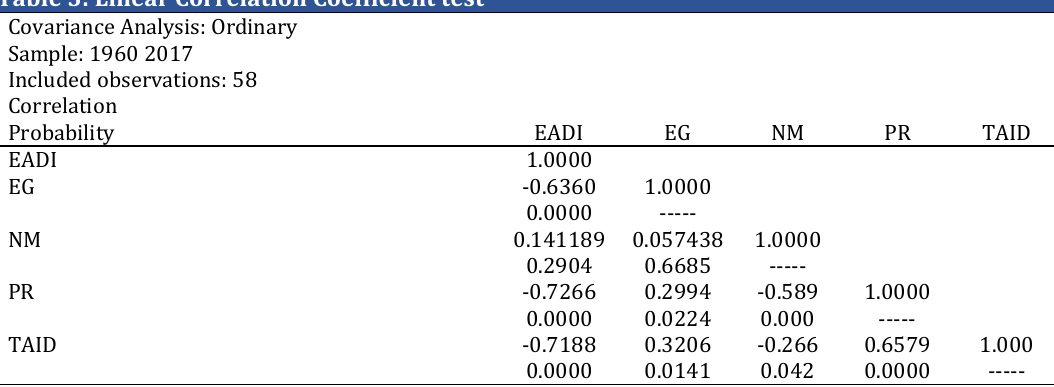
Table 3: Linear Correlation Coefficient test